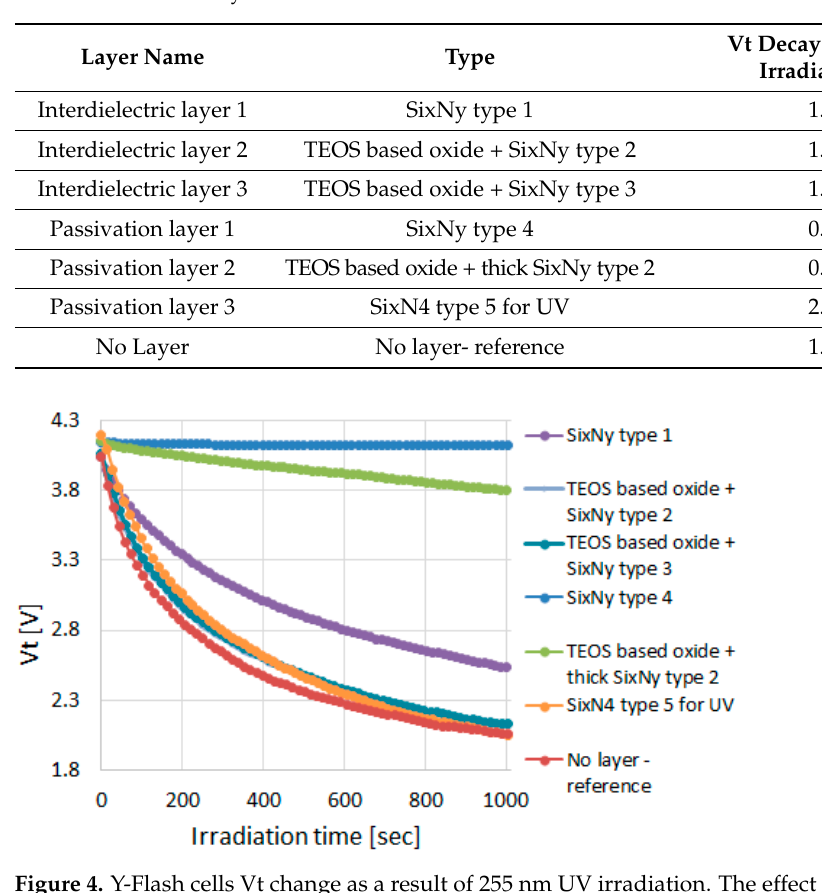
Table 1. Evaluated Layers at Back End.